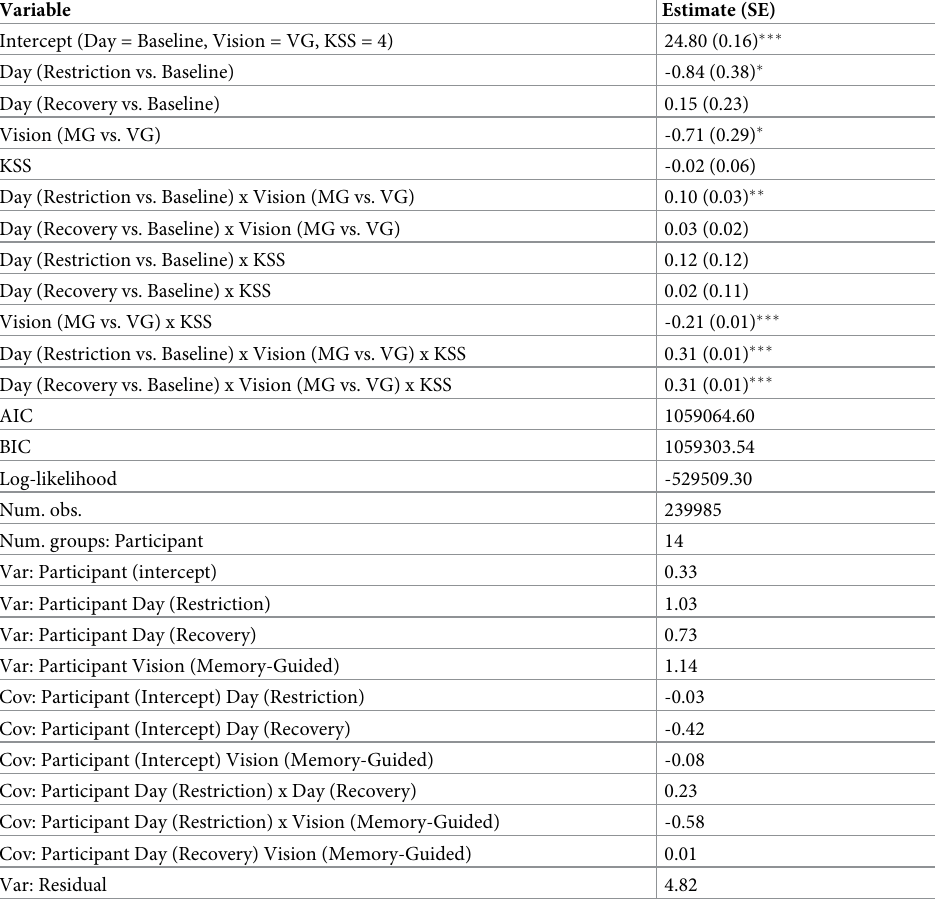
Table 2. Results of the multilevel mixed-effects model estimating mean force (%MVC).